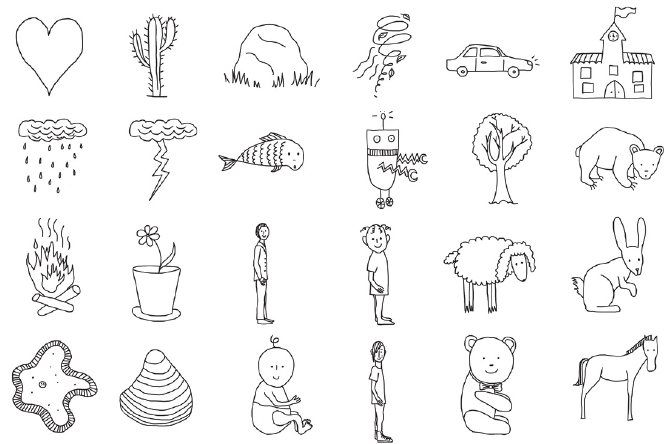
Figure 3 : The full set of images used in the